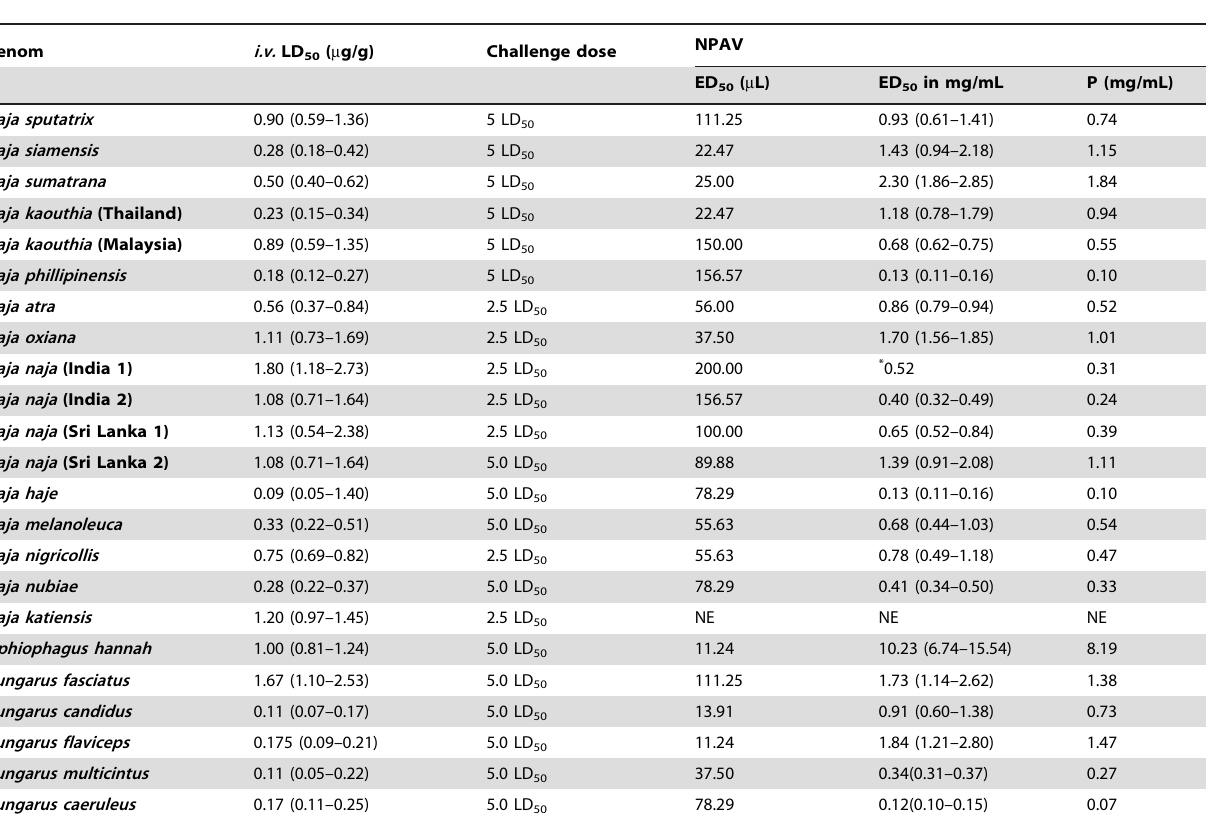
Table 1. In vitro neutralization of lethality of Afro-Asian cobra and krait venoms by NPAV.